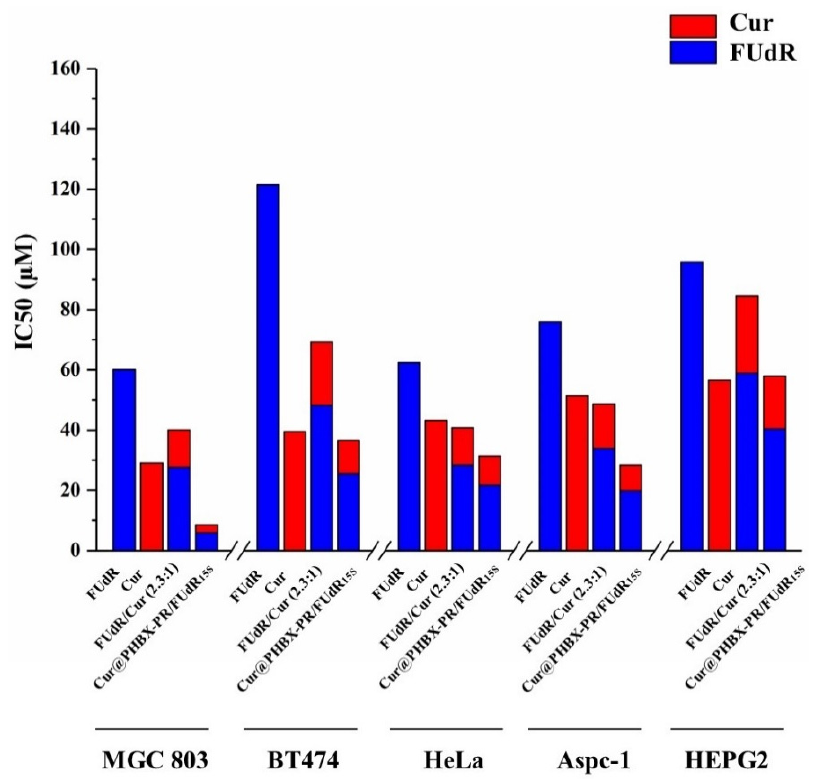
Figure 6. The IC50 values in different cell lines in MTT assay. The IC50 values of FUdR, Cur alone, and in combination in cells of MGC 803, BT474, HeLa, Aspc-1, and HEPG2 were determined using an online calculator.